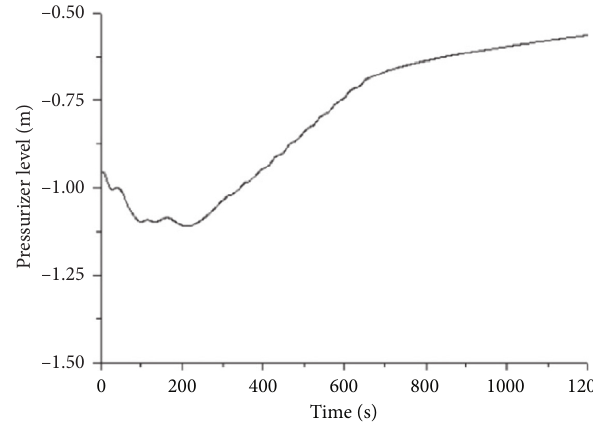
Figure 6: The transient water level of the pressurizer with the linear increase in the